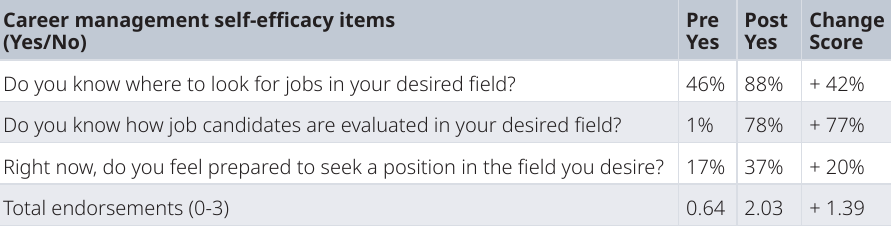
Table 4. Pre- and post-course career management self-efficacy (HINAP). Career readiness composite variable questions, percentage of yes endorsements by item (increase or decrease